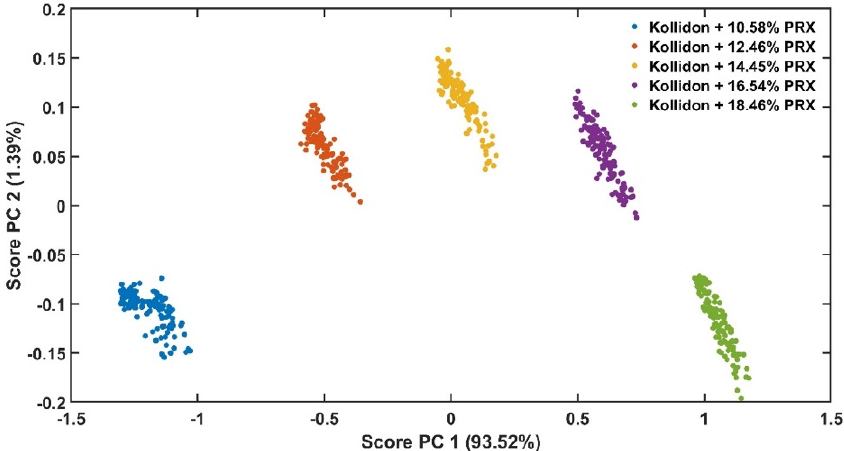
Figure 7. Scores of principal components (PC) 1 vs. PC 2 of the calibration data set.